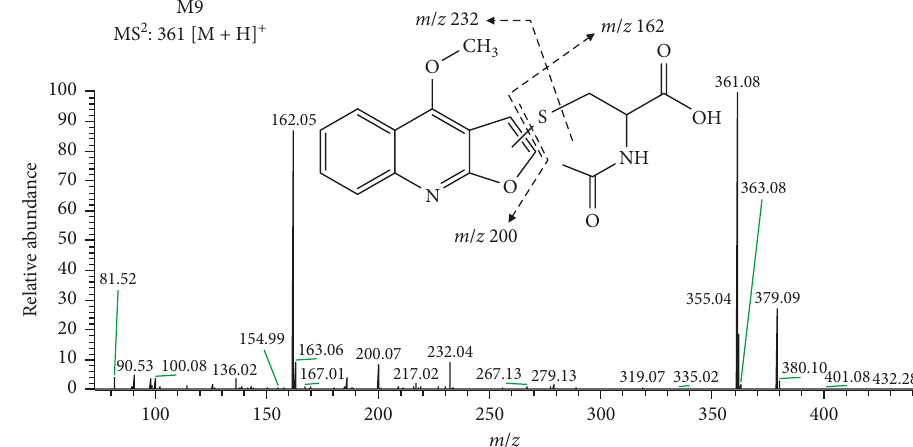
Figure 2: The proposed fragmental pathway and the MS 2 bar graph of M9.